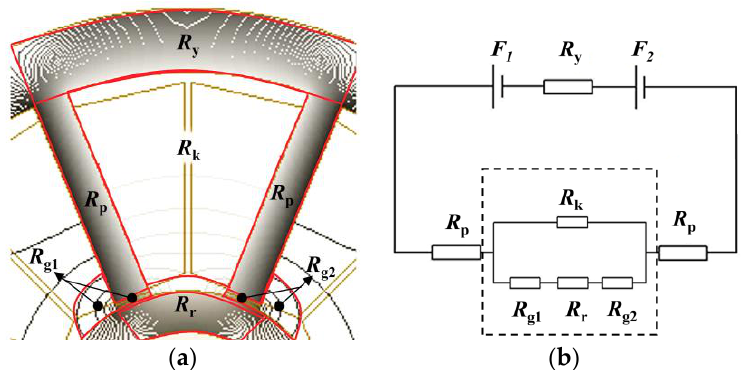
Figure 3. The nonlinear electromagnetic force modeling process by using NCMC. ( a ) Magnetic field division. ( b ) EMC for one pole pair based on NMCM. division. ( b ) EMC for one pole pair based on NMCM.